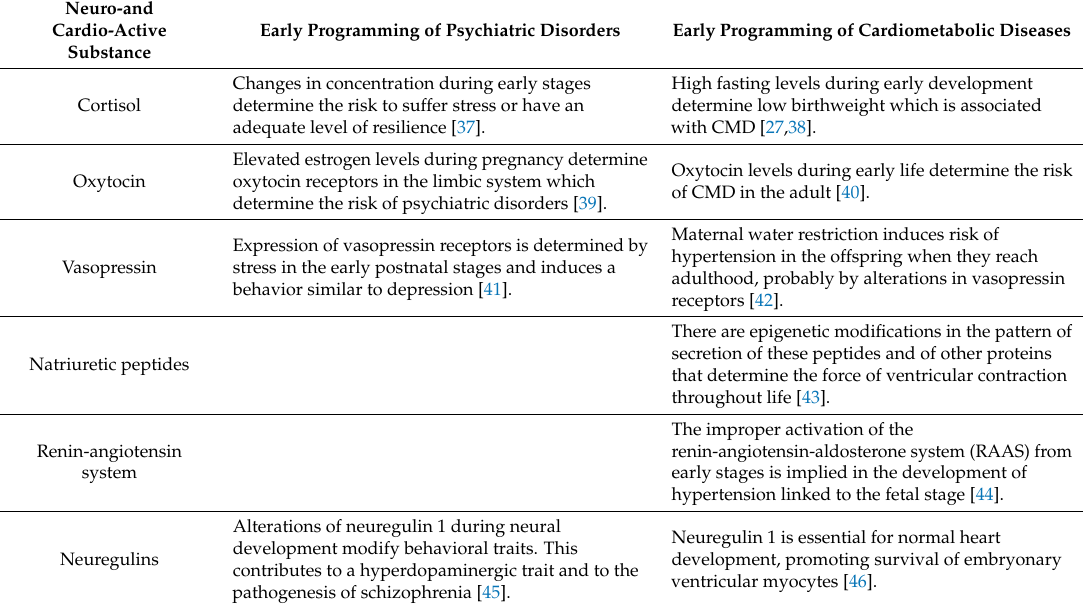
Table 1. Evidence of early programming of psychiatric and cardiometabolic diseases by neuro- and cardio-active